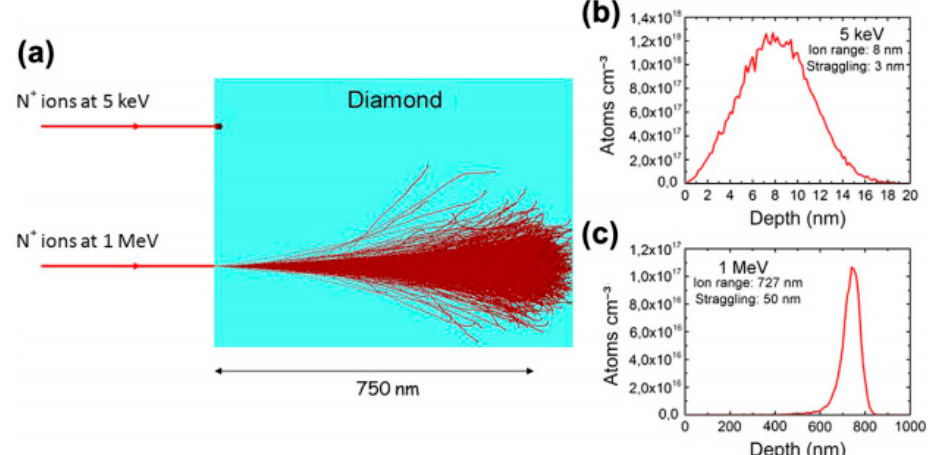
Figure 5. ( a ) Stopping and range of ions in matter (SRIM) simulation (trajectories) of nitrogen ions implanted into diamond with kinetic energies of 5 keV and 1 MeV. The need to use low ion energies to ensure low straggling and hence high-resolution implantation is shown; ( b ) Depth profile of the concentration of 5-keV nitrogen atoms calculated for a dose size of 1 × 10 12 cm − 2 ; ( c ) Depth profile of the concentration of 1-MeV nitrogen atoms calculated for the same dose size. Adapted from [37].